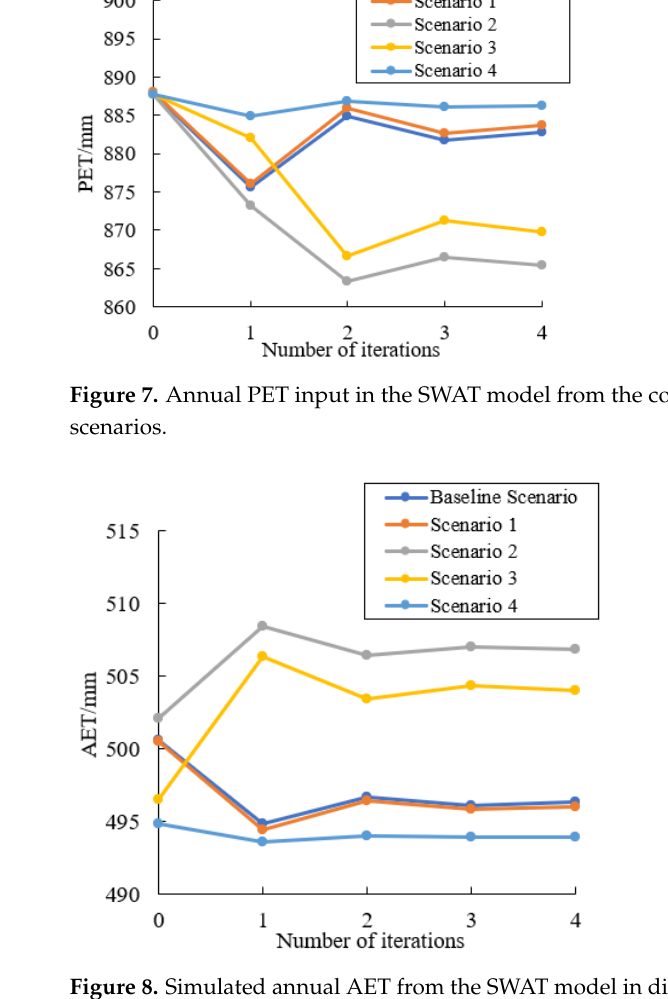
Figure 8. Simulated annual AET from the SWAT model in different scenarios.